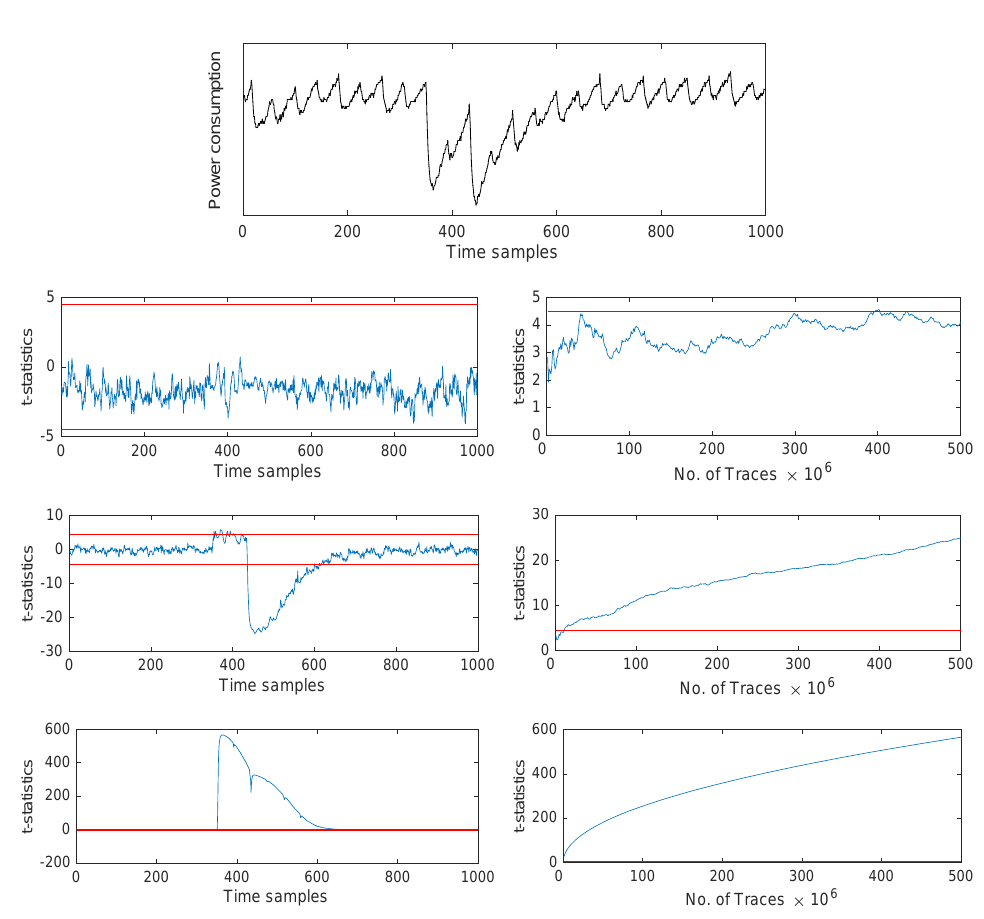
Figure 14: Sample power trace and univariate non-specific t -test results with 500 million measurements for two composed DOM- indep multiplications ( d = 2) based on GF (2 4 ) multipliers without output registers but with pipeline registers applied. The second to fourth row show the t -statistics for the statistical moments 1 to 3,